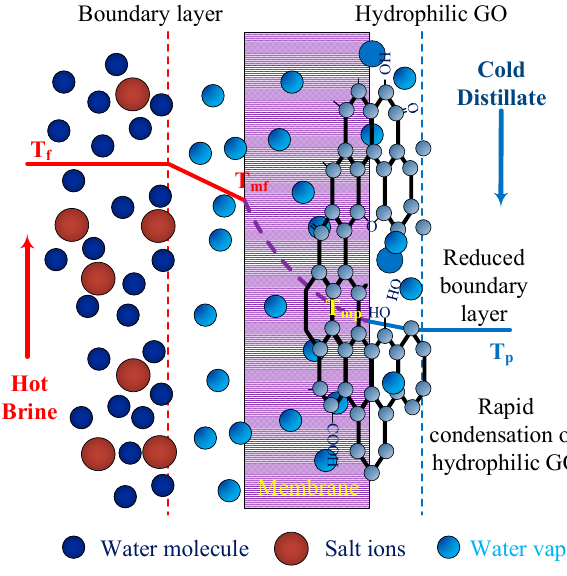
Figure 9. Proposed mechanism for GOIM-P.